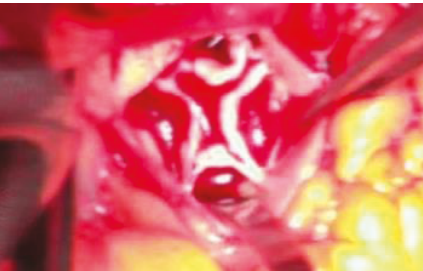
Figure 1: Intraoperative image showing quadricuspid aortic valve: Hurwitz type C/Nakamura type